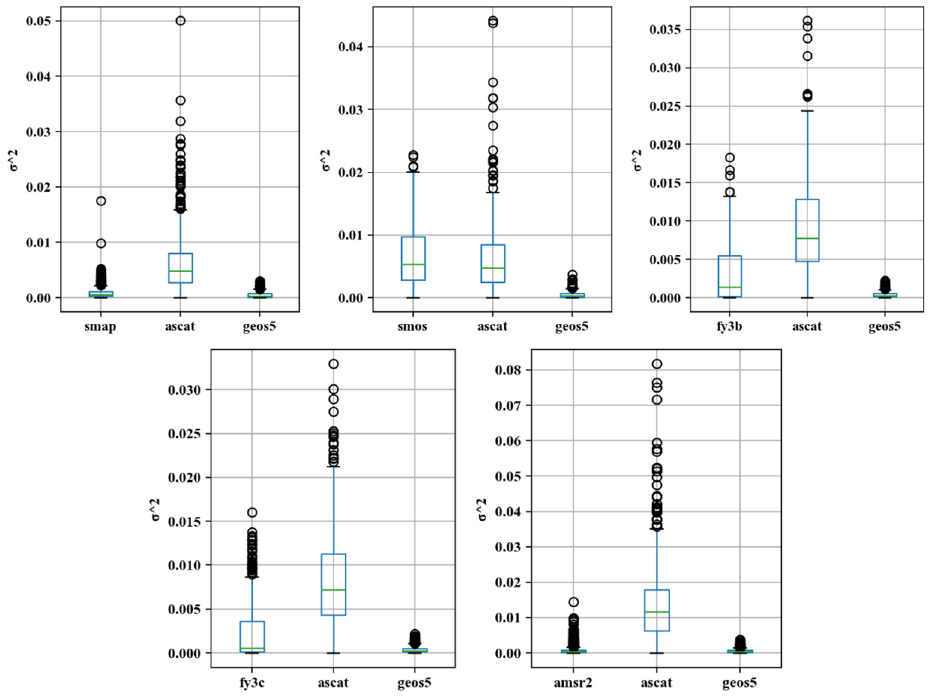
σ 2 in the study